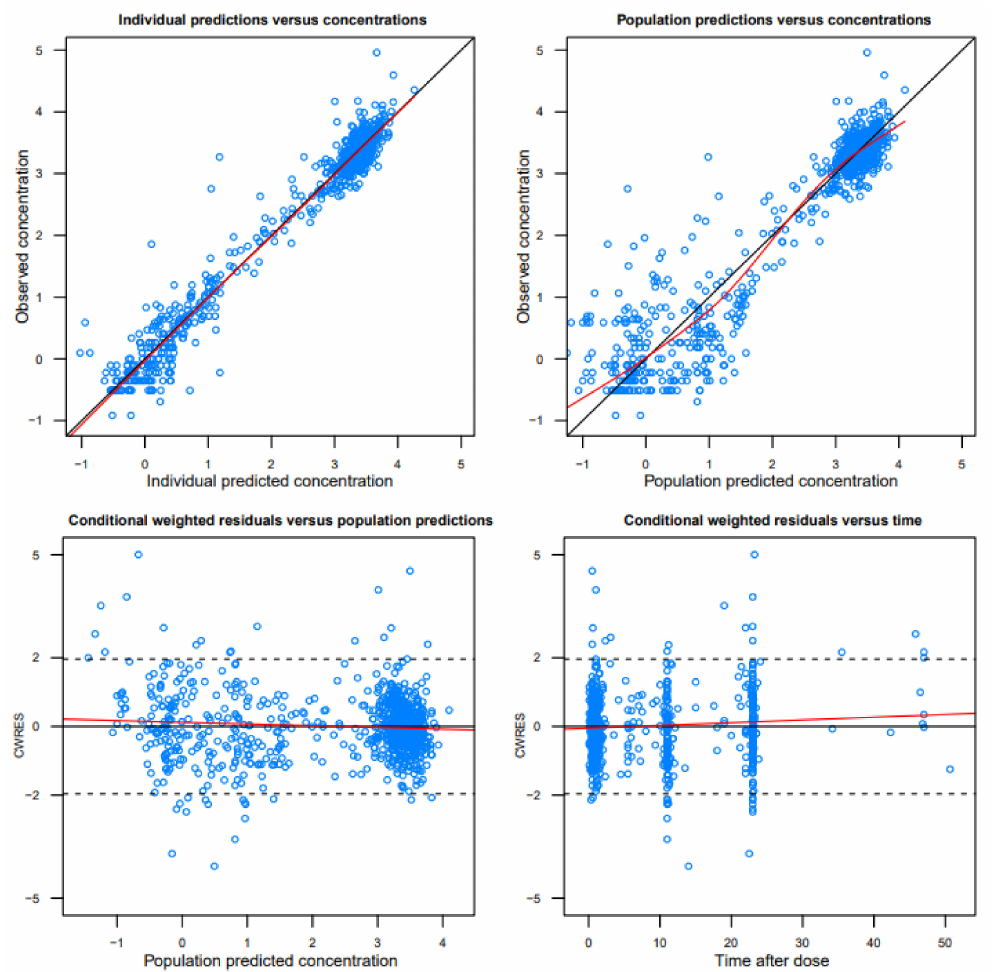
Figure 1. Goodness-of-fit plots of the final pharmacokinetic model. Open circles indicate observations; solid black lines are the lines of identity; red lines are the line of locally weighted scatterplot